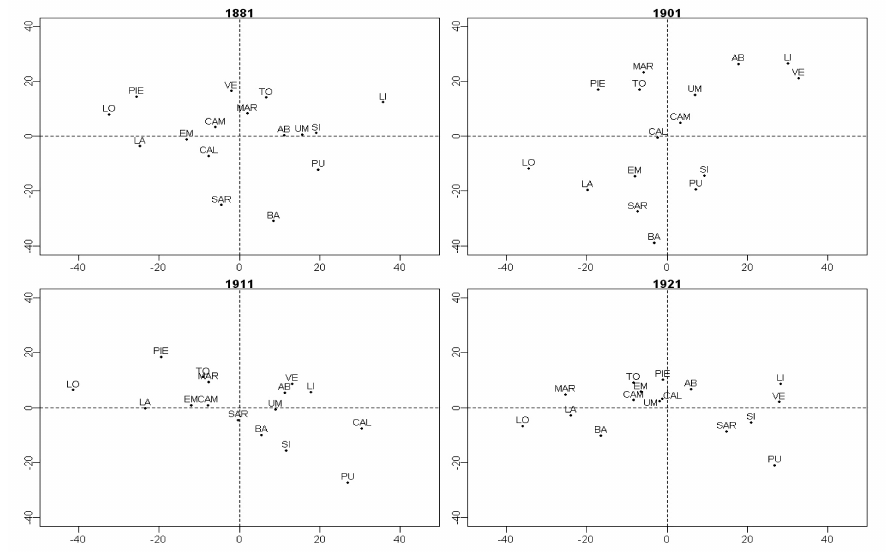
Figure 6 − Projections of the regions on the compromise in each occasion: Piemonte (PI), Liguria (LI), Lomabrdia (LO), Veneto (VE), Emilia (EM), Toscana (TO), Umbria (UM), Marche (MAR), Lazio (LA), Abruzzi (AB), Campania (CAM), Puglia (PU), Basilicata (BA), Calabria (CAL), Sicilia (SI) and Sardegna